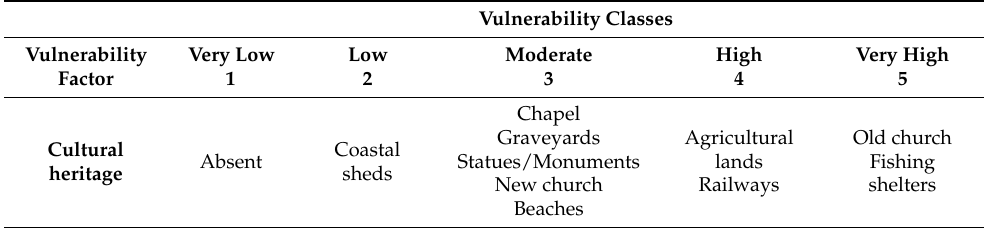
Table 14. Vulnerability classification concerning the cultural heritage vulnerability